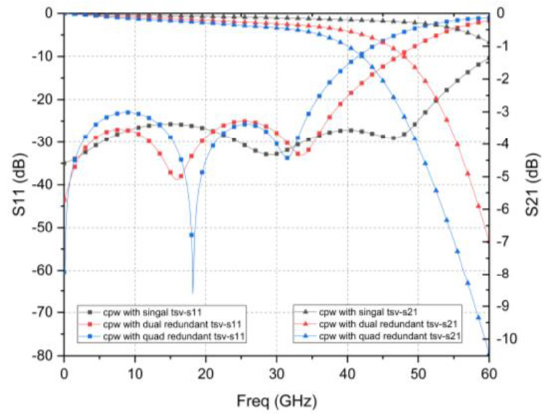
Figure 2. Test structure simulation result.